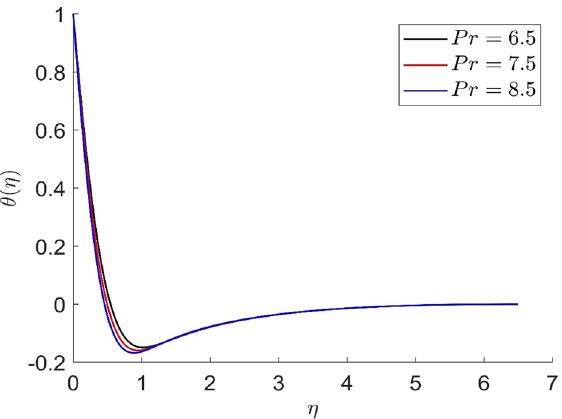
Figure 20. Representation of temperature θ(η) for the different values of Pr with R = 3, n = 3, v = 0.7, m = 1.5, φ 2 = 0.8, φ = 0.3, φ 1 = 0.1, β 3 = 0.5, β = 0.4, β 1 = 0.5, β 2 = 0.9, u = 0.2, ξ = 0.2.